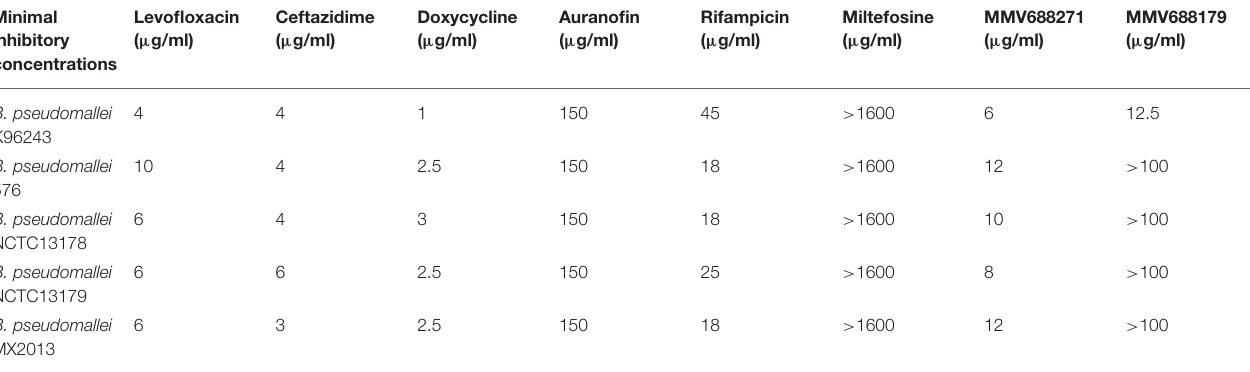
TABLE 2 | Minimal Inhibitory Concentrations. Minimal inhibitory